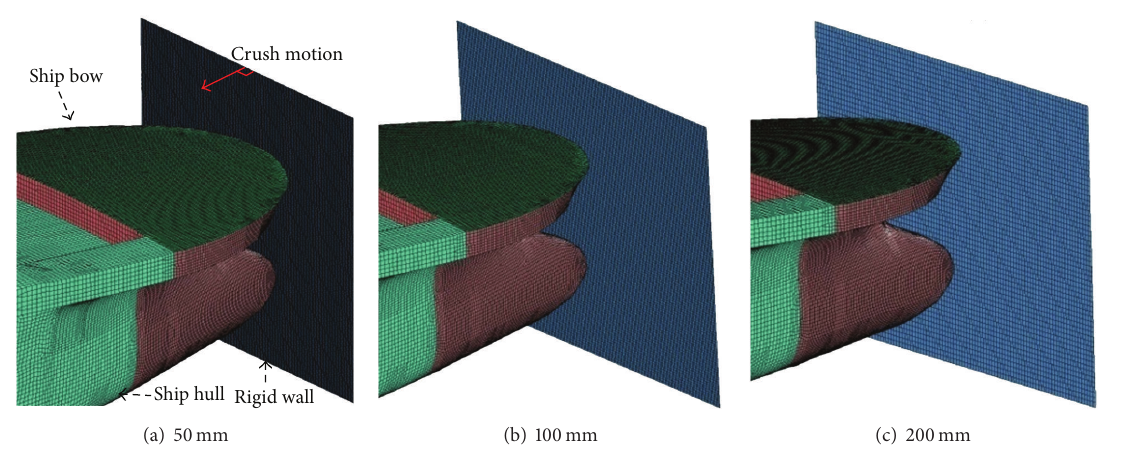
Figure 3: Crush analysis model with different mesh sizes of the rigid